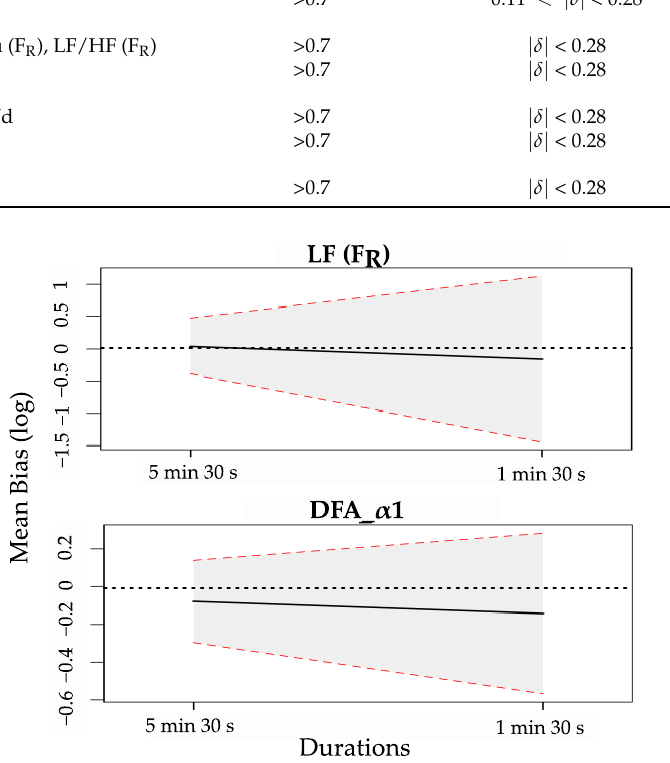
Figure 4. Changes in mean bias and 95% limits of agreement (LoA) for low frequency and DFA- α 1 features with decreasing the duration of recording from 5 min 30 s to 1 min 30 s. The black line indicates the mean of observed bias, the dotted red lines show the intervals defined by the 95% LoA, and the dotted black line represents the line of equality with null bias. Table 2. Features showing good agreement between PPG 25 Hz (1 min 30 s) and ECG